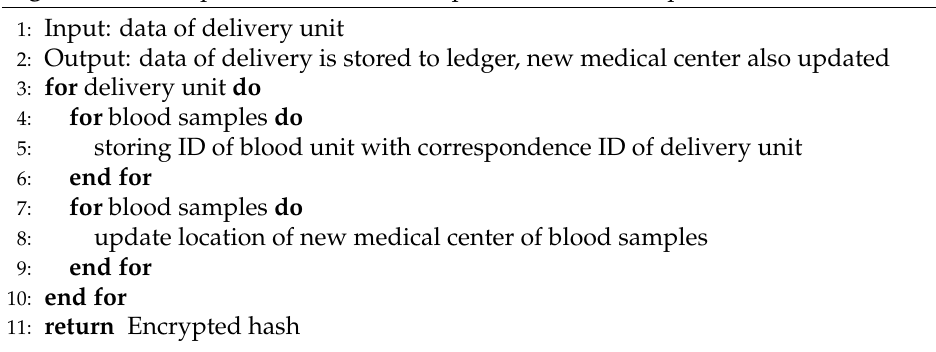
Algorithm 2 transportation of blood samples from donation places to medical center.